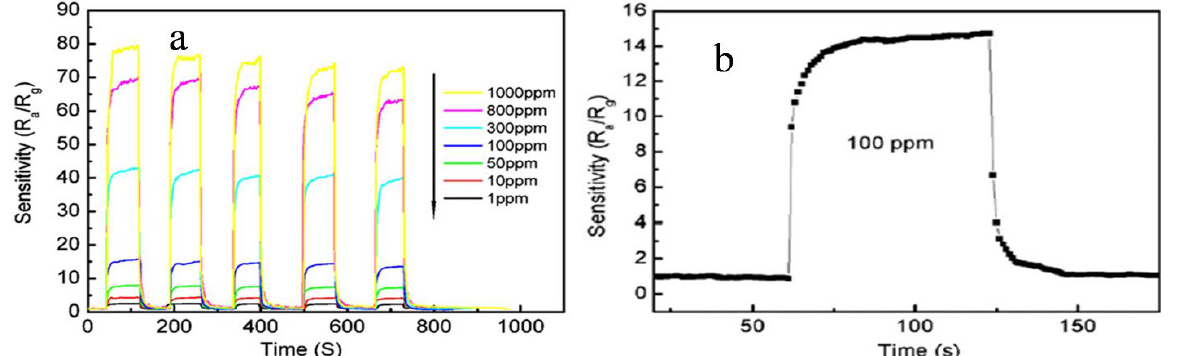
Figure 6. ( a ) Schematic representation of the different sensing characteristics of SnO 2 hollow spheres upon exposure to different ethanol concentrations ranging from 1 to 1000 ppm; ( b ) sensor response and recovery times of different SnO 2 hollow spheres to 100 ppm of ethanol for one cycle (Reprinted with permission from [38]. Copyright 2008, Elsevier).